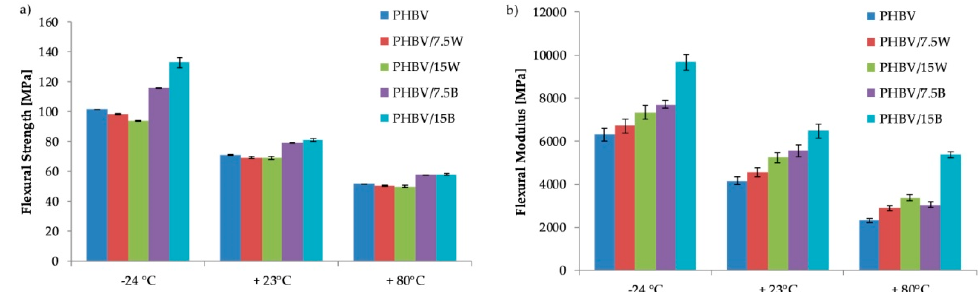
Figure 4. Flexural properties of PHBV and its composites at − 24, 23 and 80 °C: ( a ) flexural strength and ( b ) flexural modulus.